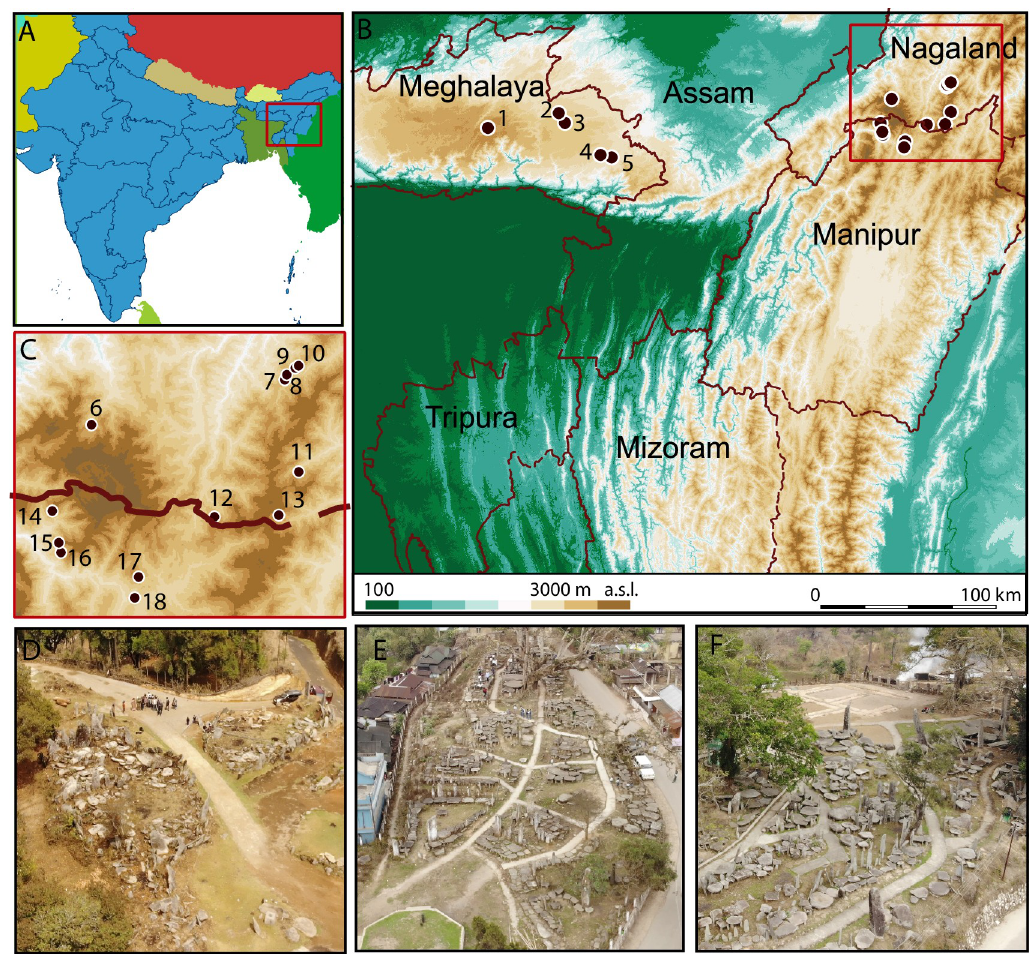
Fig 1. Overview of the research area in Northeast India. A-C: sites with field surveys, D: Myllem, Meghalaya, E: Nartiang, Meghalaya, F: Nongbag, Meghalaya (Data provisioning and graphic: RGK Frankfurt, UFG Kiel; shape files made with Natural Earth, DEM based on CGIAR-CSI SRTM data. DEM republished from Jarvis A., H.I. Reuter, A. Nelson, E. Guevara, 2008, Hole- filled seamless SRTM data V4, International Centre for Tropical Agriculture (CIAT), available from